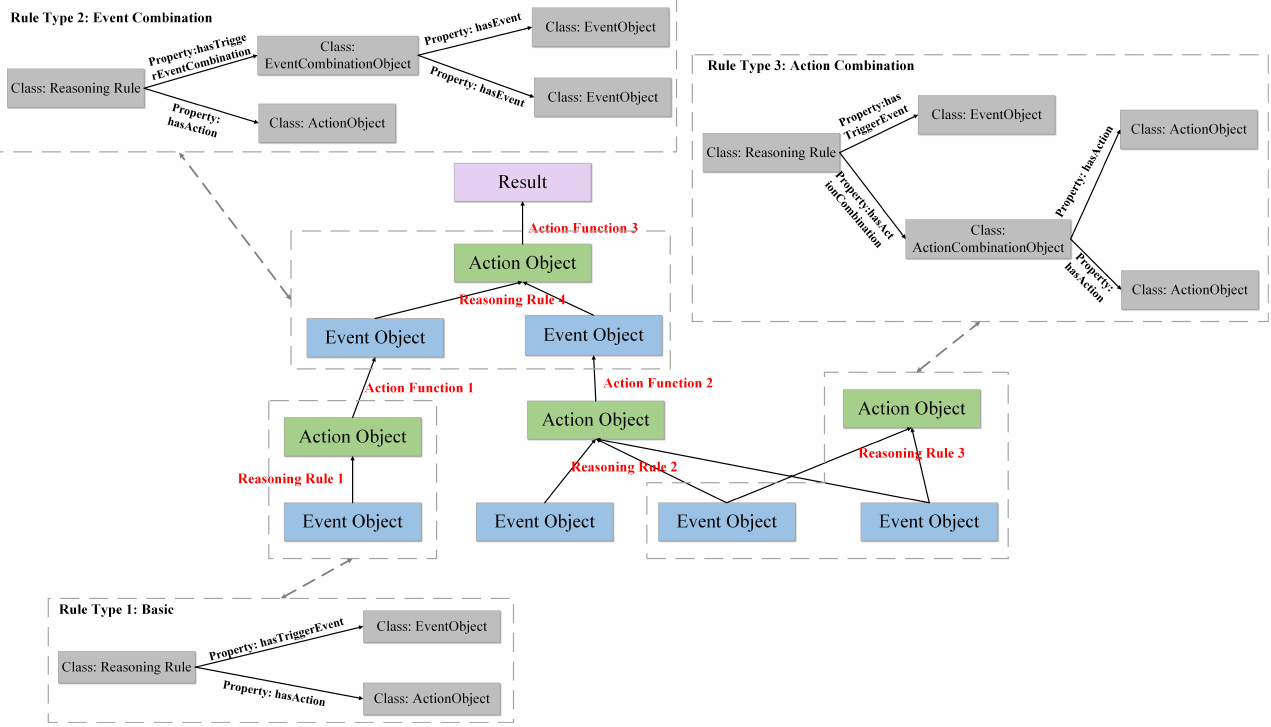
Figure 7. Template for completing phase reasoning from multiple events, and three types of rules, including one event triggering one action, event combination triggering one action, and one event triggering action